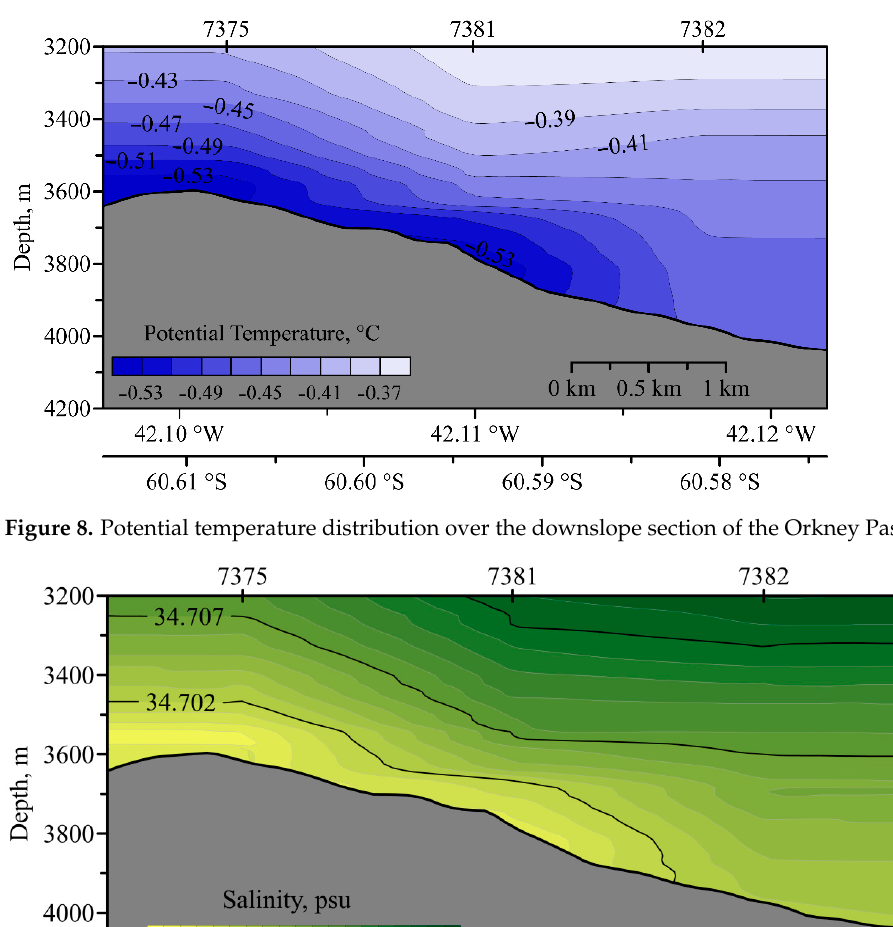
Figure 7. Longitudinal velocity (through flow) section downslope the Orkney Passage. Contour line of 0.356 m/s is additionally shown.